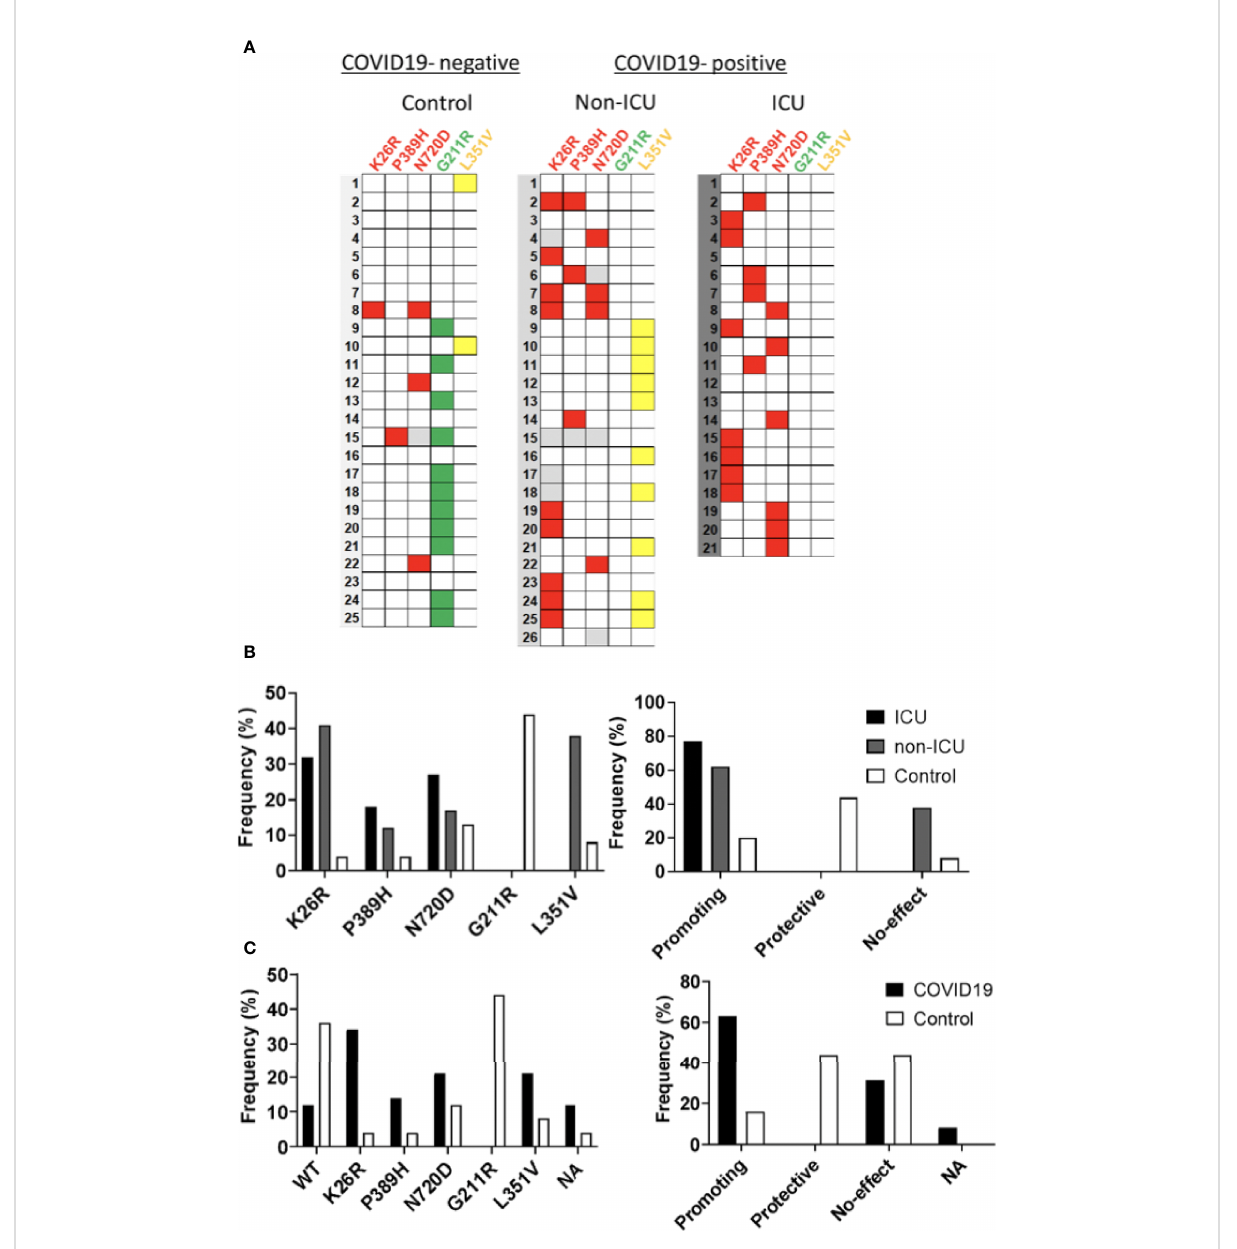
FIGURE 11 Infection-promoting ACE2 SNPs are a risk factor for COVID19 susceptibility. (A) Heatmap showing the distribution of ACE2 variants in the hospitalization severity groups. Coloured squares indicate de presence of the ACE2 variants. Red: Promoting; Green: Protective; Yellow: No- effect. (B) Frequencies of ACE2 SNPs among hospitalization severity groups. Bars represent frequencies of the SNP in each group (C) Frequencies of ACE2 SNPS among susceptibility